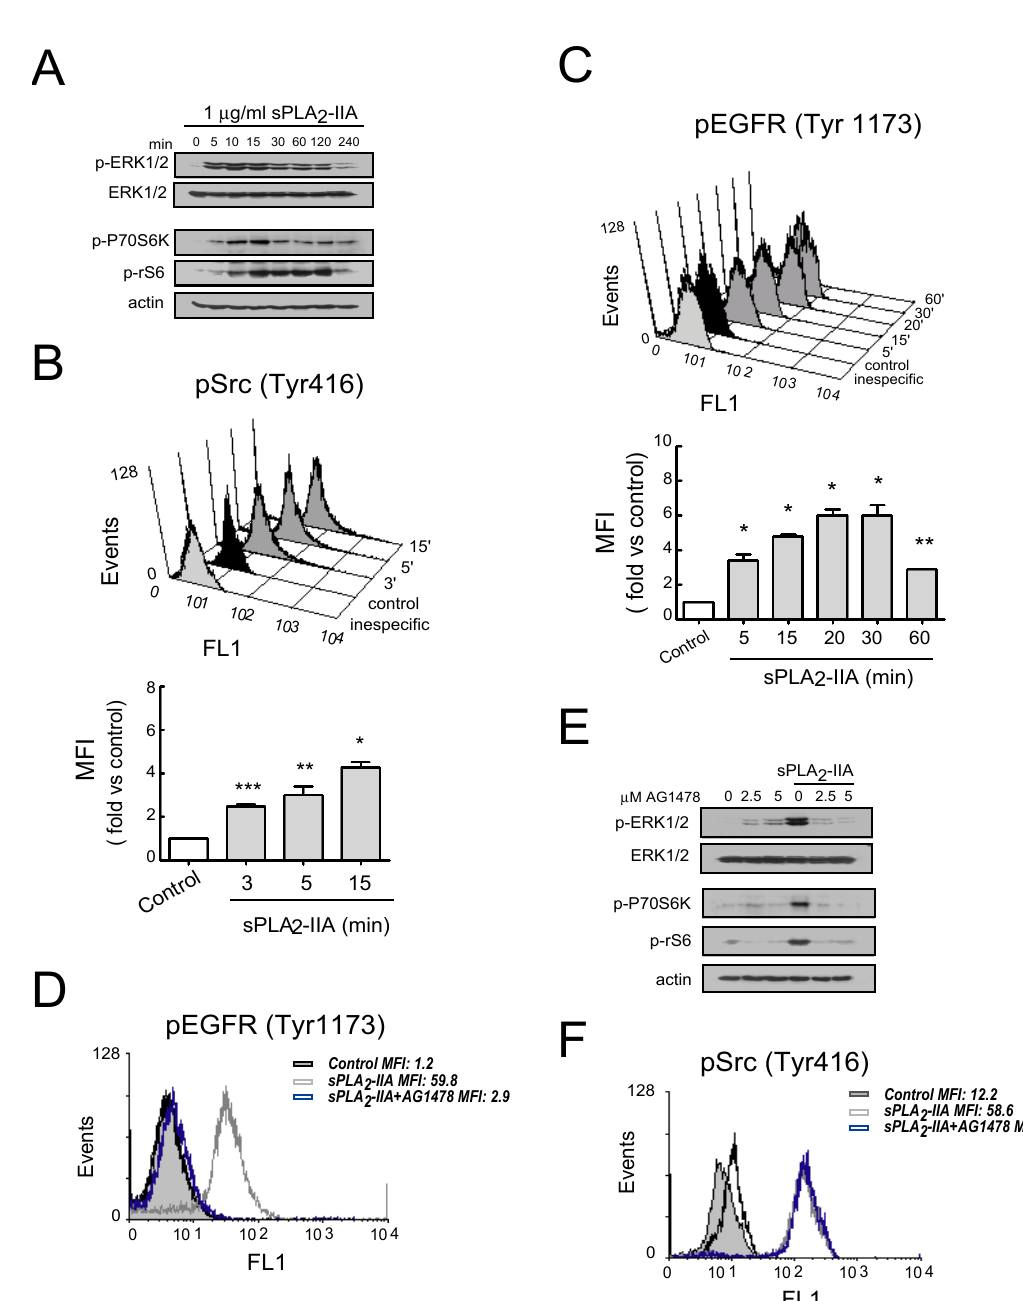
Figure 4. sPLA 2 -IIA-activated intracellular signaling cascades in cardiac fibroblast (CFs) requires EGFR transactivation Cells were stimulated with 1 µ g / mL of sPLA 2 -IIA for indicated times: using phospho-specific antibodies, ( A ) ERK, Akt, P70S6 and S6 phosphorylation were determined by immunoblotting, while ( B ) Src and ( C ) EGFR phosphorylation was examined by flow cytometry. Untreated (solid black curves) and sPLA 2 -IIA-treated (solid dark grey curves) CFs were compared with isotype controls (solid light grey curves). ( D–F ) Cells were pretreated with AG1478 before stimulation with sPLA 2 -IIA. ( D ) After 15 min, phospho-EGFR was studied by flow cytometry. ( E ) After 15 min, ERK, Akt, P70S6 and S6 phosphorylation were determined by immunoblotting, while ( F ) Src phosphorylation was studied by flow cytometry. Untreated (open black curves), sPLA 2 -IIA-treated (open grey curves), AG1478+sPLA 2 -IIA-treated (open blue curves) CFs were compared with isotype controls (solid light grey curves). * p < 0.001, ** p < 0.01 and *** p < 0.5 vs. control cells; mean ± SD; n =